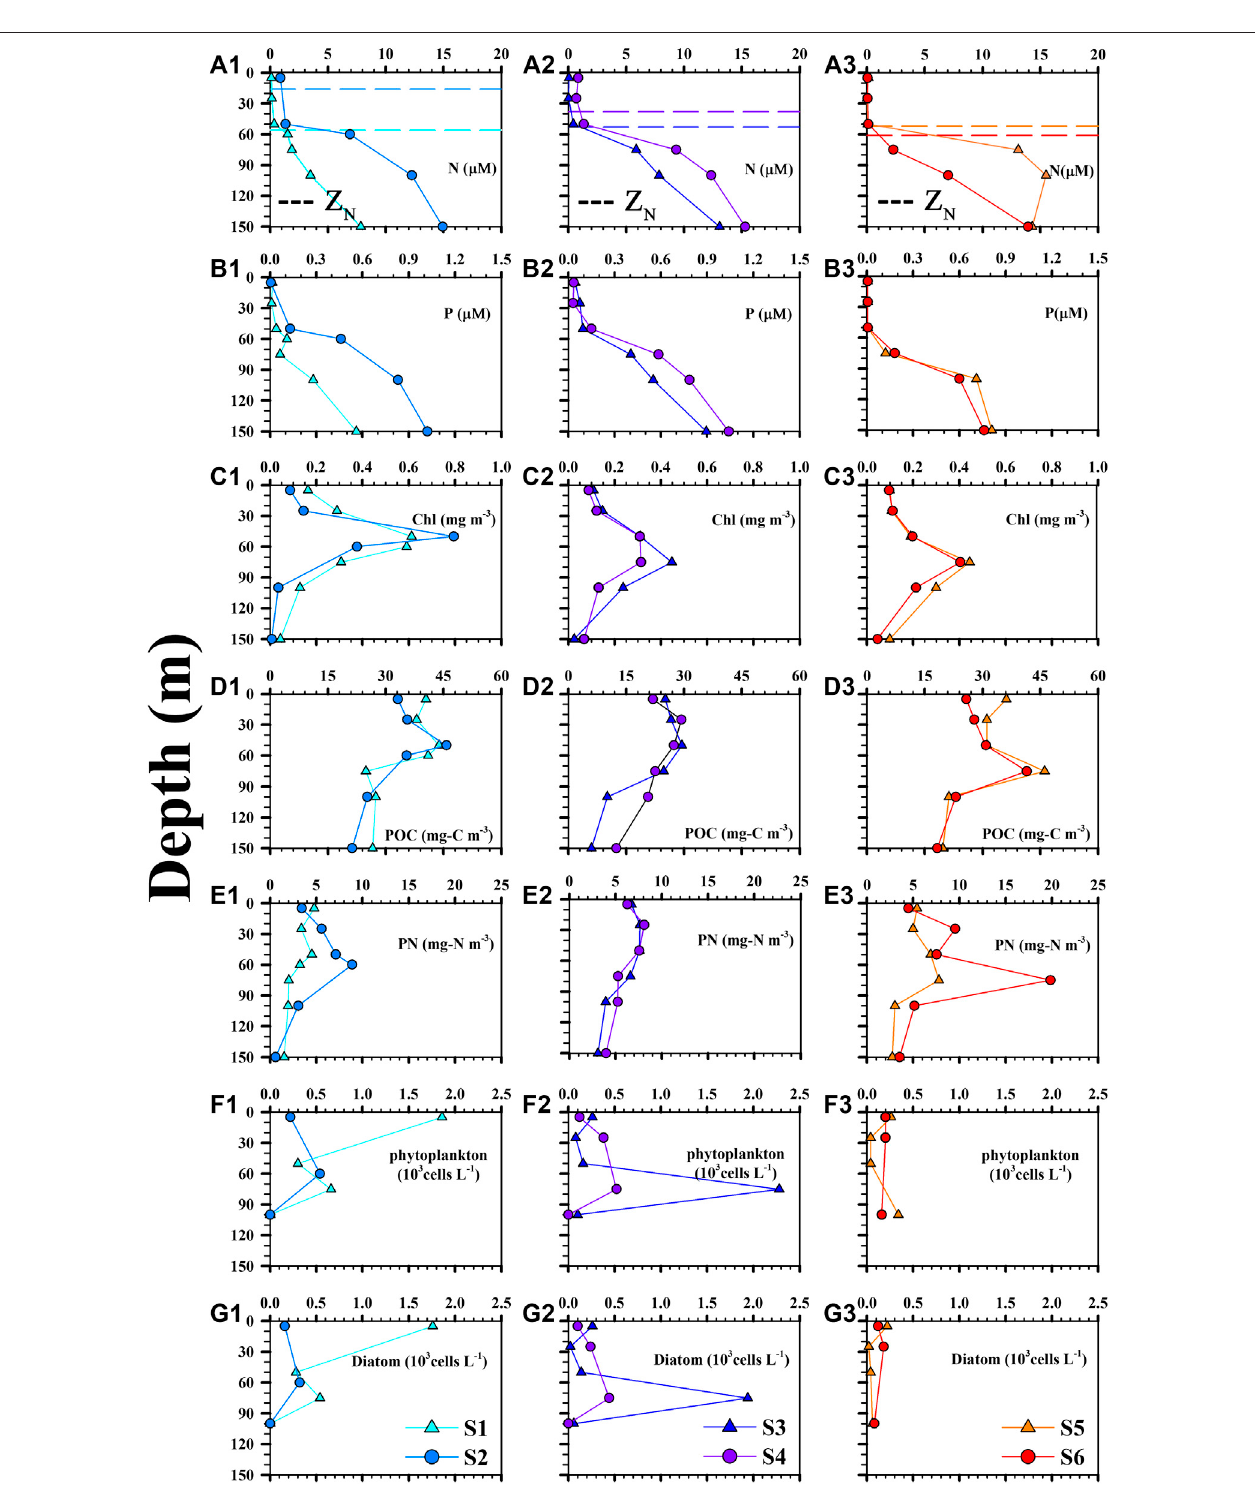
FIGURE 2 | Vertical pro fi les of (A1 – A3) nitrate + nitrite (N), (B1 – B3) phosphate (P), (C1 – C3) chlorophyll (Chl), (D1 – D3) POC, (E1 – E3) PN, (F1 – F3) phytoplankton abundanceand (G1 – G3) diatomabundanceatstationsS1(CE),S2(CE),S3(CE),S4(CE),S5(WE)andS6(WE).Horizontaldashedlinesin A1 – A3 representthedepthof the nitracline (Z N ).